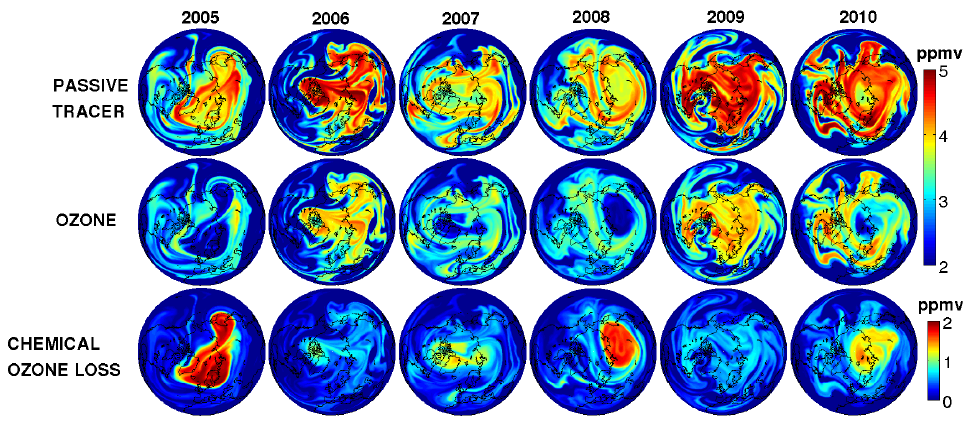
Fig. 3. Maps of passive tracer, ozone, and chemical ozone loss (passive tracer-ozone) calculated by Mimosa-Chim at 475K on 15 March